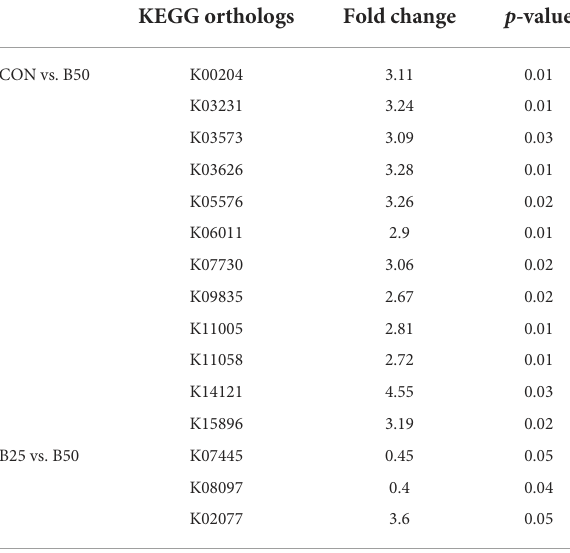
TABLE 5 Significant differential KEGG orthologs of functional prediction in fecal microorganisms. KEGG orthologs Fold change p -value CON vs.